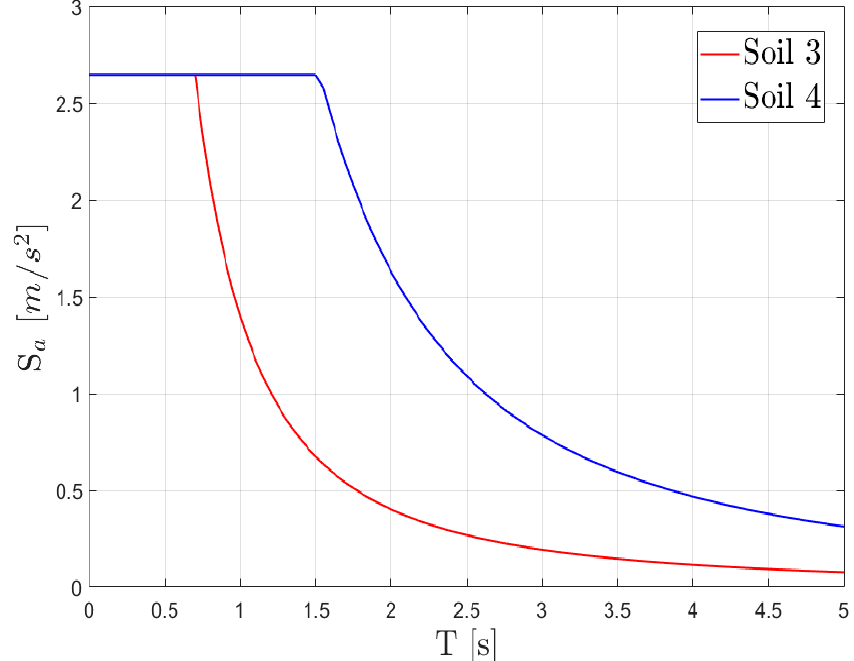
Figure 3. Design spectrum according to NCh2369 [12].